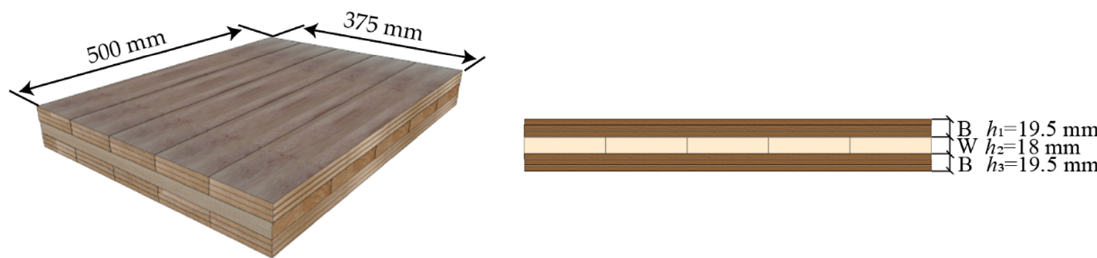
Figure 1. Schematic illustration of CLBT panel configuration.